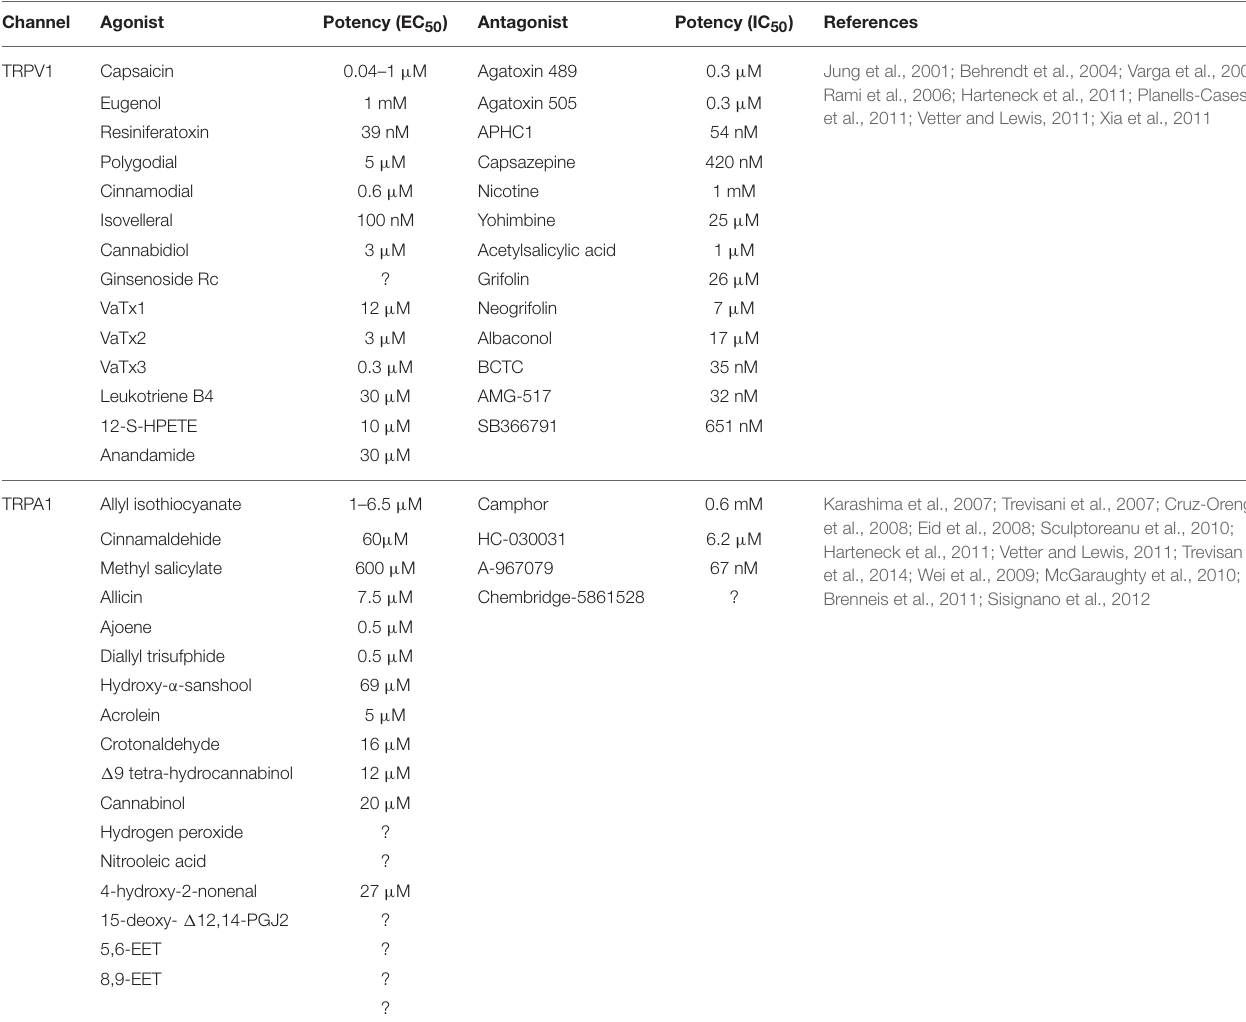
TABLE 1 | Agonists and antagonists of TRPV1 and TRPA1